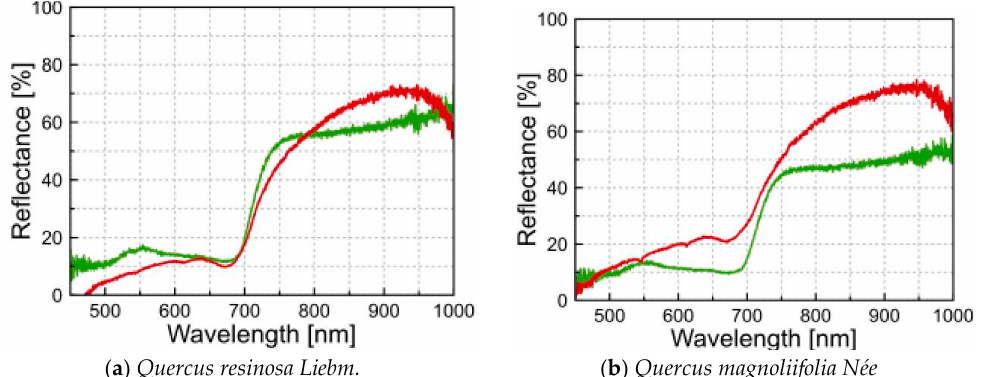
Figure 2. Measured spectral reflectance in Vis-NIR range of ( a ) Quercus resinosa Liebm. and ( b ) Quercus magnoliifolia Née (after [5]). Green line is the spectrum of a fresh leaf (green upon visual inspection), and red corresponds to the senescent leaf (brown upon visual